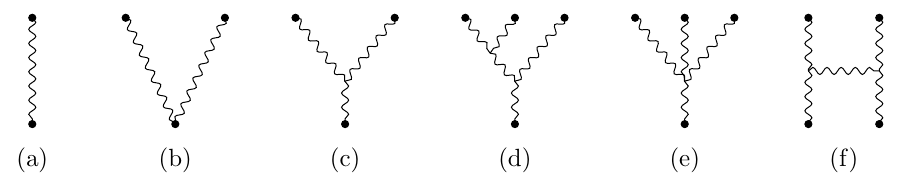
Figure 3. Sample of Feynman diagrams needed for the computation of the scattering angle in the EFT approach to 3PM order. Only the diagrams to one-loop order in (a)-(c) are needed to